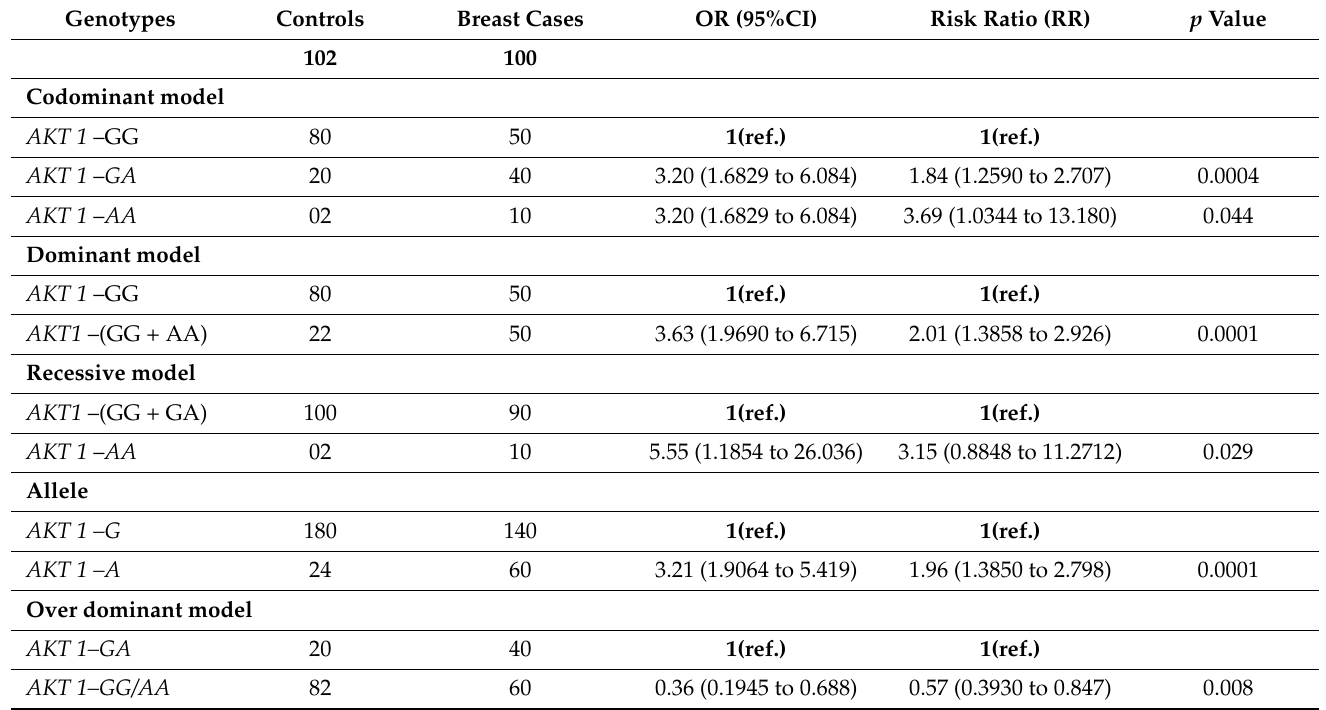
Table 4. Association of AKT 1 rs1130233 G > A genotypes with Breast cancer